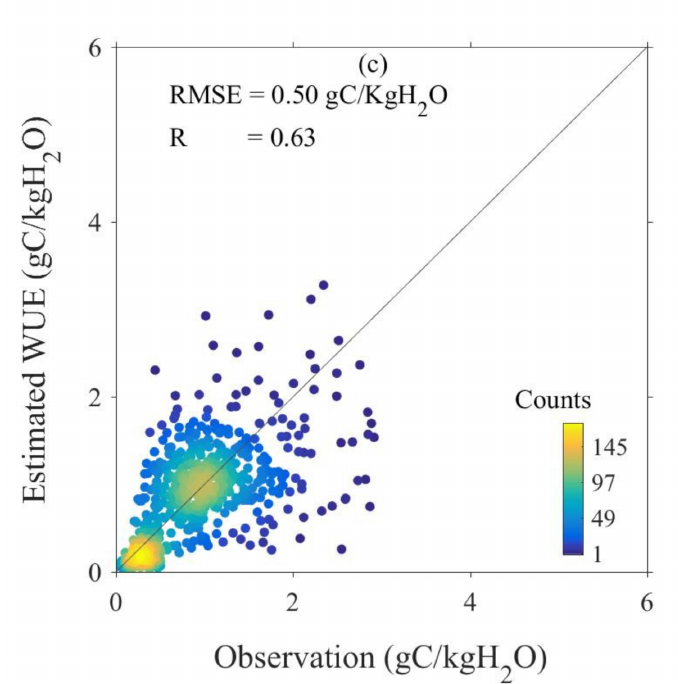
Figure 3. Scatterplots of observed ( a ) evapotranspiration (ET), ( b ) gross primary productivity (GPP), and ( c ) water-use efficiency (WUE), and associated estimates obtained from remote sensing model over cropland (maize) cover types at Daman superstation